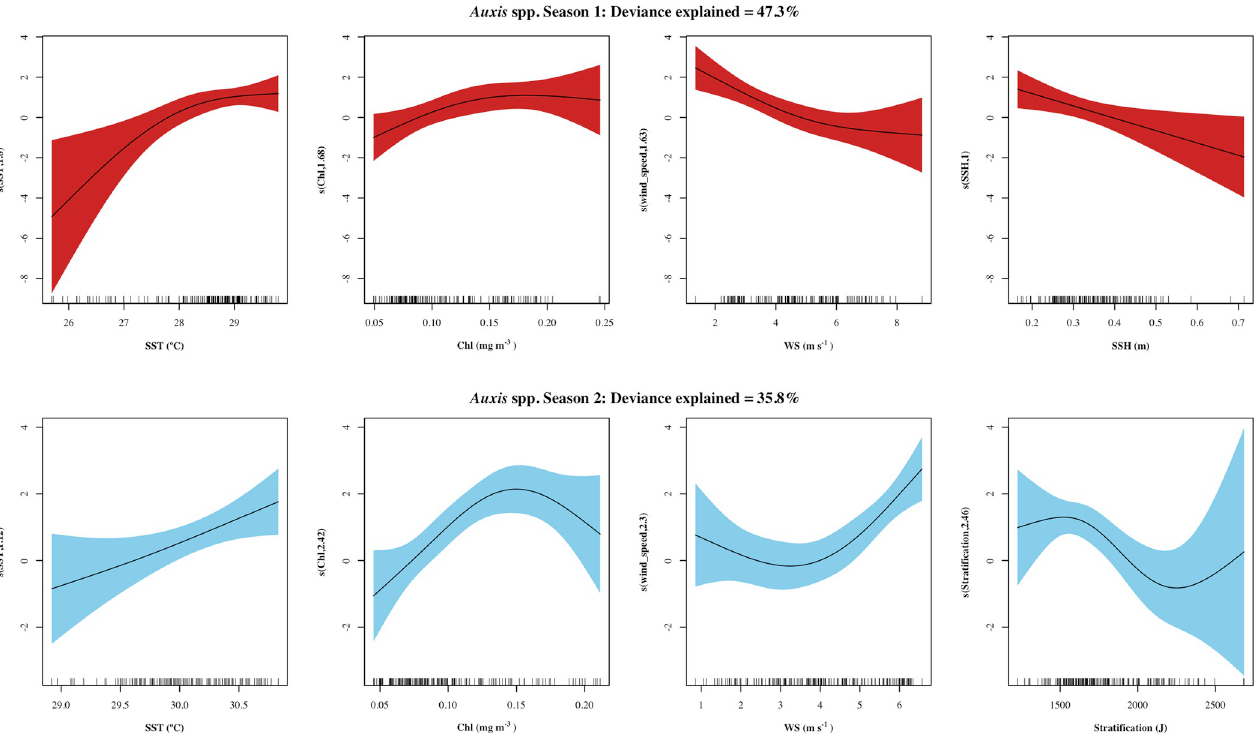
Fig 3. Response plots of the oceanographic variables’ additive effect on the density of Auxis spp. Season I (April-July) in red and season II (August- October) in blue. Smoothed values represented by a continuous line, and shaded color indicates 95% confidence intervals. variables with non-significant additive effects (p > 0.05) for a given season are not